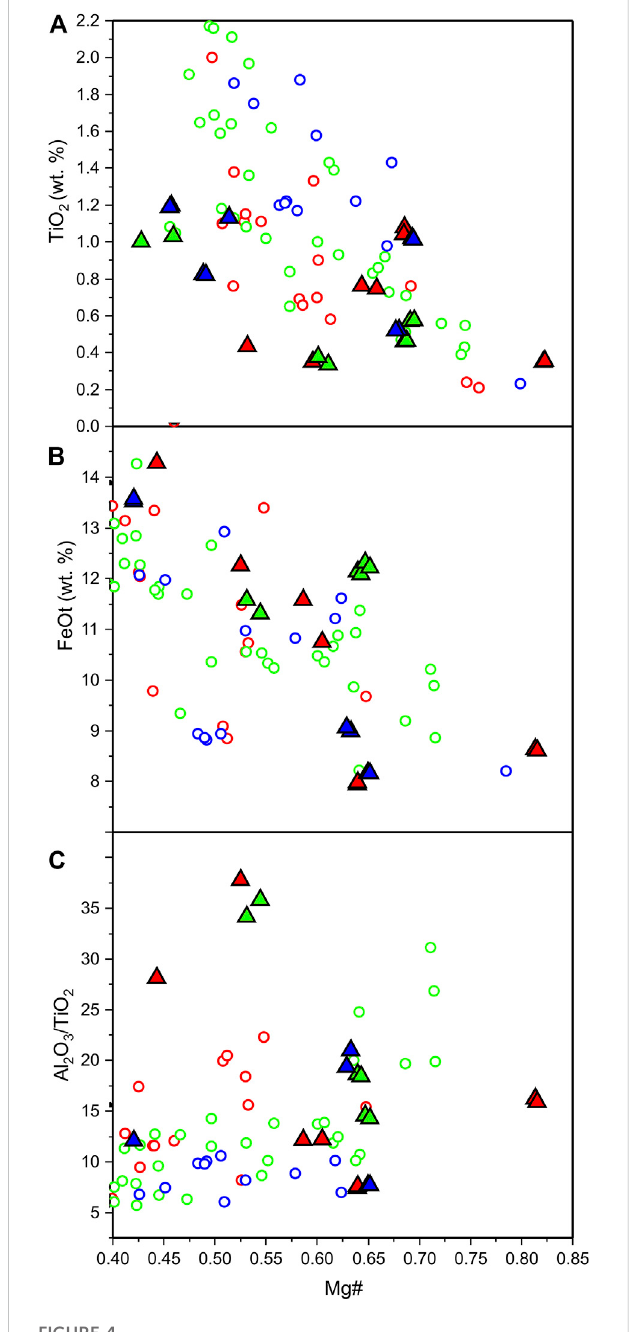
FIGURE 4 ThevariationsofwholerockMg-number(Mg#)against (A) TiO 2 , (B) FeOt and (C) Al 2 O 3 /TiO 2 . The symbols are the same as in Figure